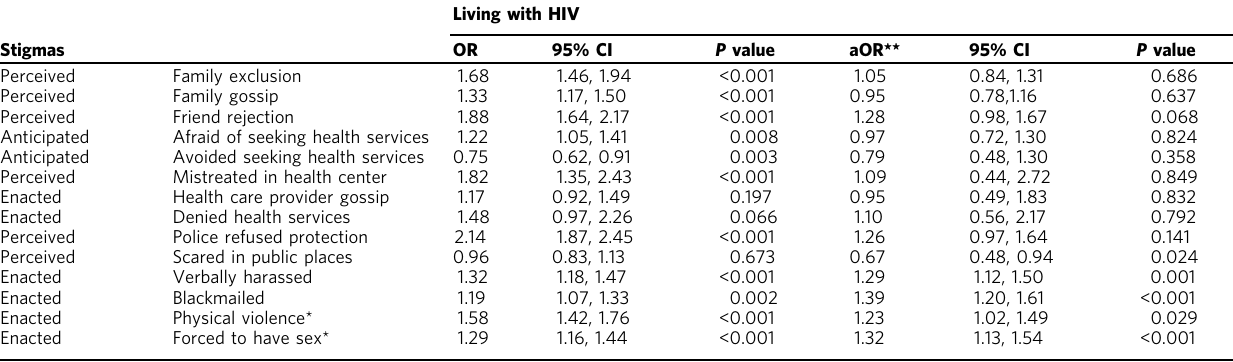
Table 5 Pooled relationship between stigma and prevalent HIV infection among female sex workers.